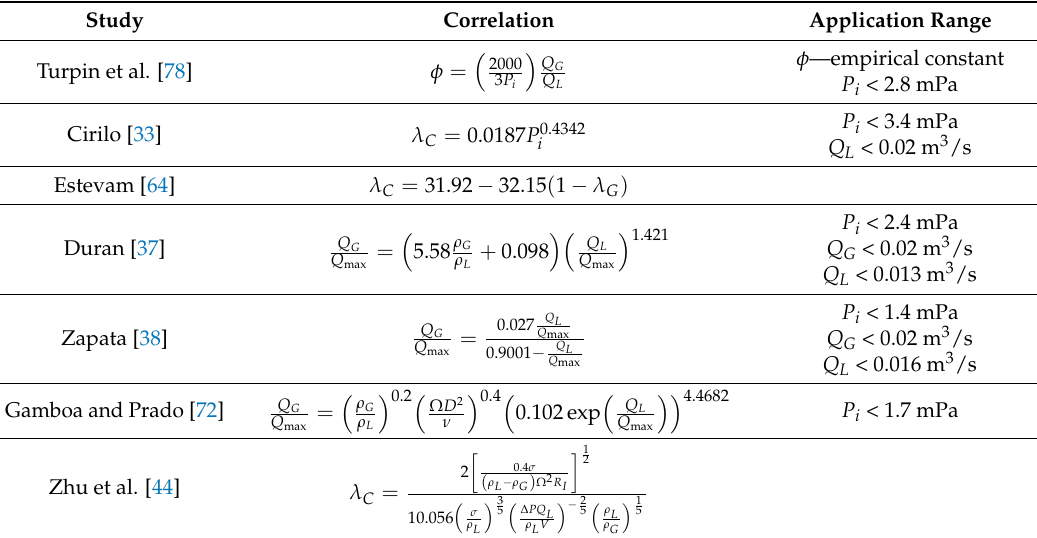
Table 9. Correlations of surging initiation (1st transition boundary) in